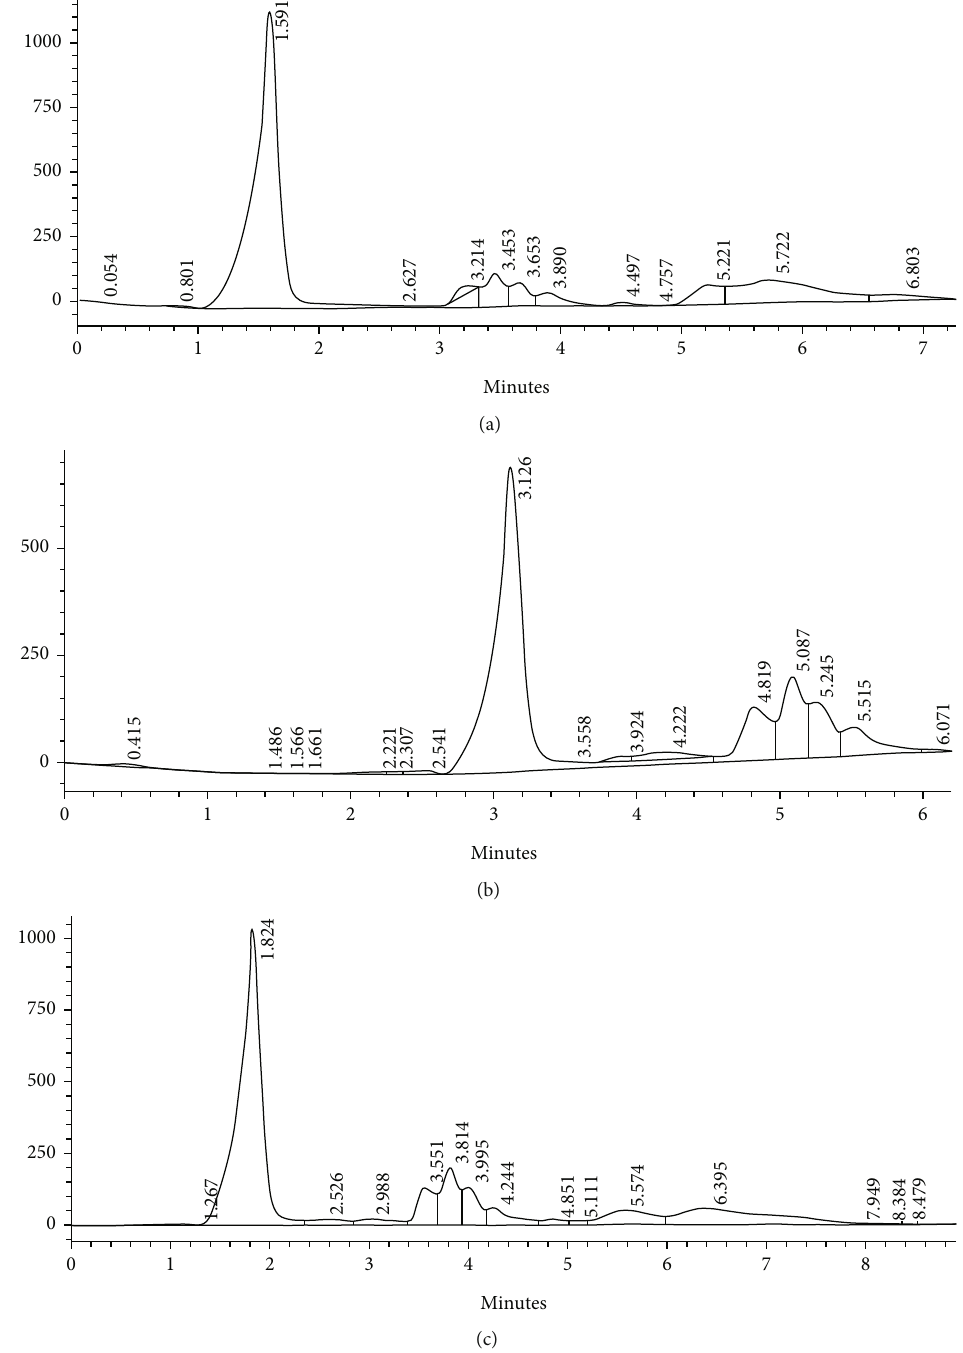
Figure 1: E ff ect of exposure to sunlight on the formation of vitamins D (60 min), and (c) exposed to sunlight